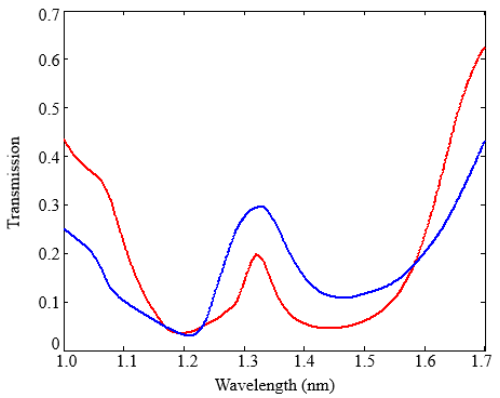
Figure 8. Transmission spectrum of the plasmonic cavity with N = 6 (blue curve) and N = 8 (red curve).